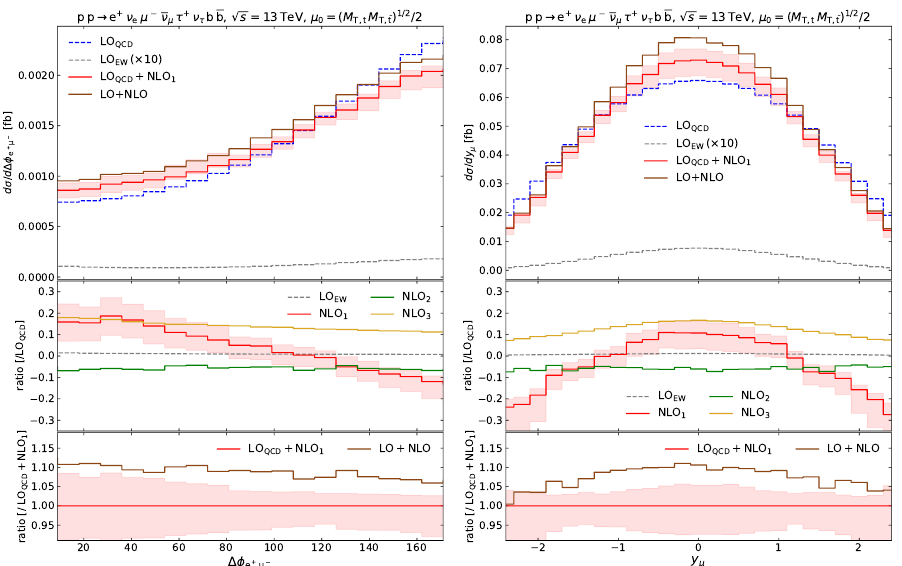
Figure 5: Distributions in the azimuthal separation betwen the positron and the muon (left) and in the muon rapidity (right). Top: differential cross-sections in fb for + NLO LO , LO , LO and for complete NLO (sum of all LO cross-sections QCD EW QCD 1 and NLO corrections). Middle: ratios of LO , NLO , NLO , and NLO corrections EW 1 2 3 over the LO cross-section. Bottom: ratios of LO + NLO cross-section over the QCD + NLO LO one. Uncertainties from seven-point scale variations are shown for QCD 1 + NLO LO QCD 1